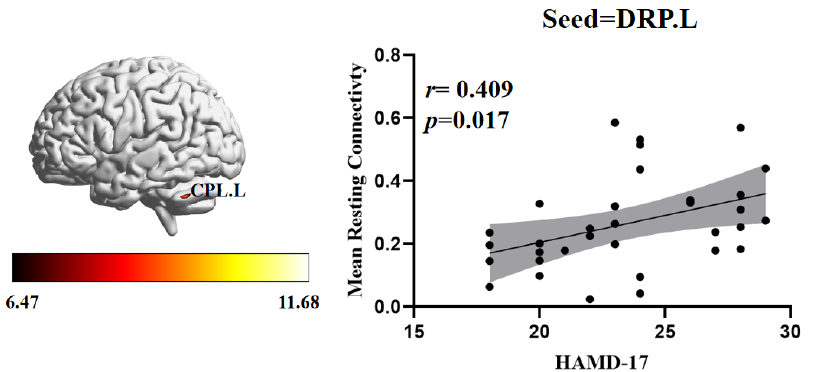
Figure 4. Positive correlation between the FC of abnormal brain regions and the HAMD-17 scores: FC values in the RDE group. CPL.L, left cerebellum posterior lobe; DRP.L, left dorsal rostral puta- men.